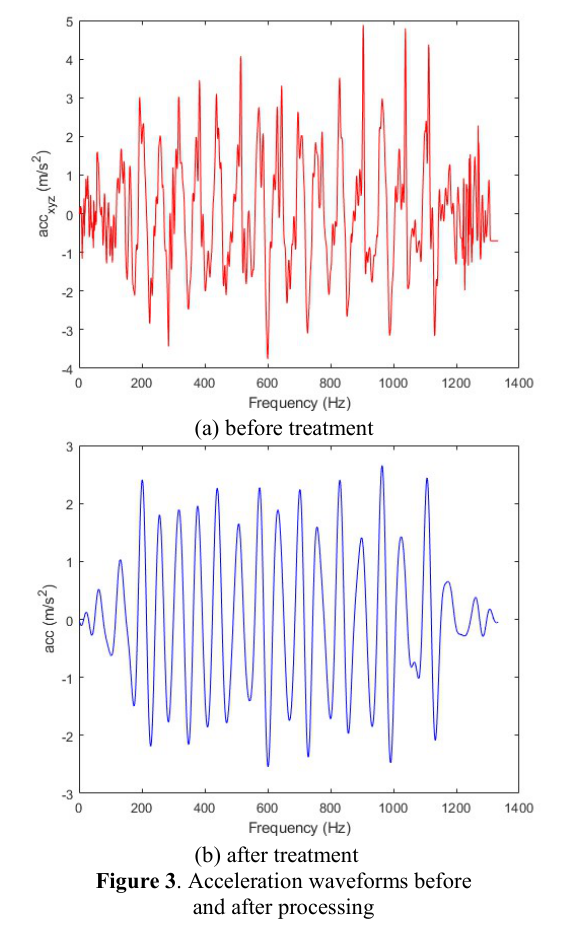
Figure 3 . Acceleration waveforms before and after